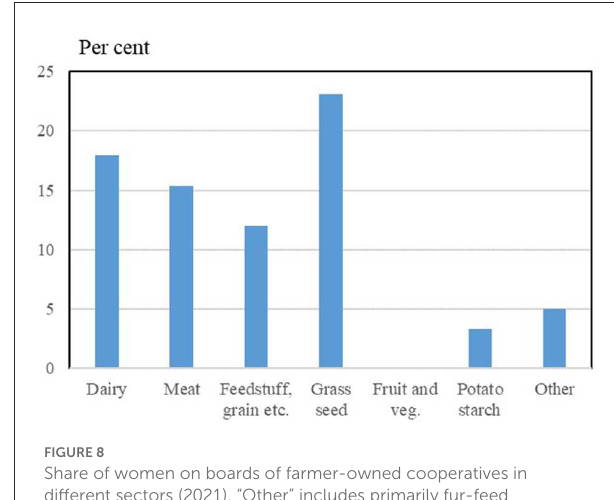
FIGURE7 External members of Danish farmer-owned cooperatives: Male and females. Source: Own data collection and presentation based on annual reports and homepages of 25 farmers owned cooperatives in Denmark.